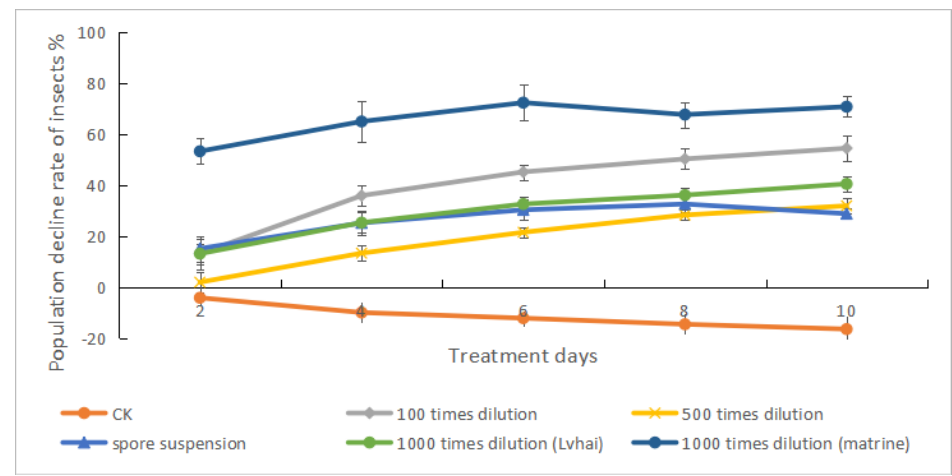
Figure 4. Effects of different treatment agents on the population decline rate of P. bilinealis larvae. Bars represent standard errors of three replicates.